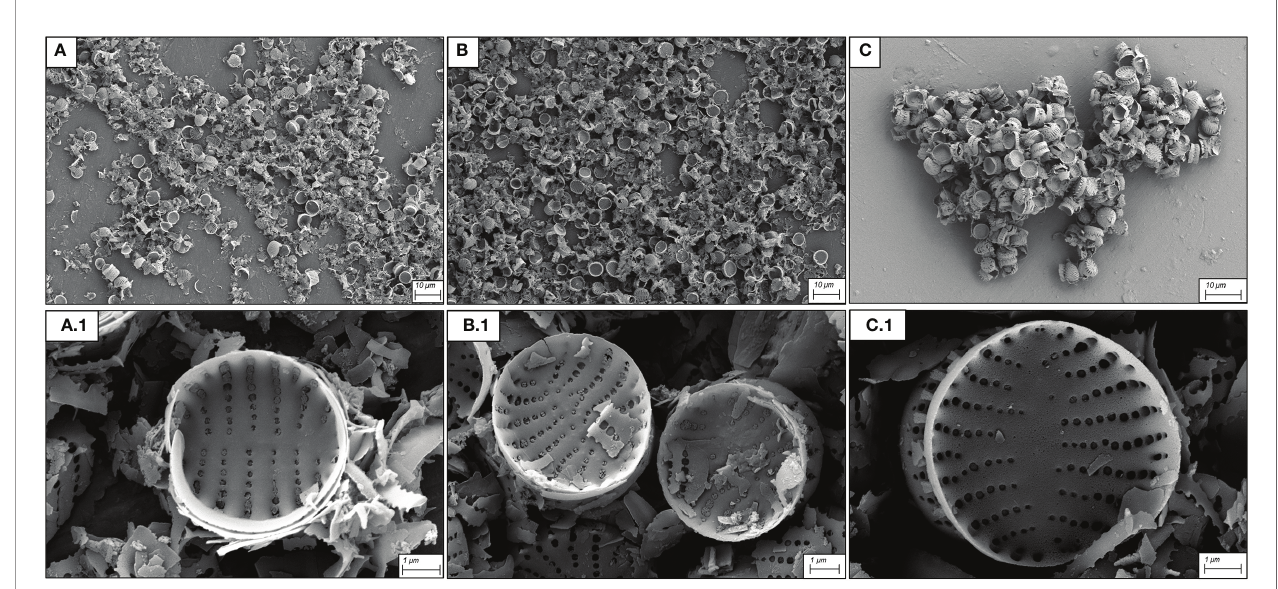
FIGURE 1 | SEM micrographs of S. pinnata valves obtained with different hot acid cleaning protocols. (A) H 2 SO 4 :HNO 3 :H 2 O (3:1:1 v/v/v) at 90°C for 2 h; (B) : HNO